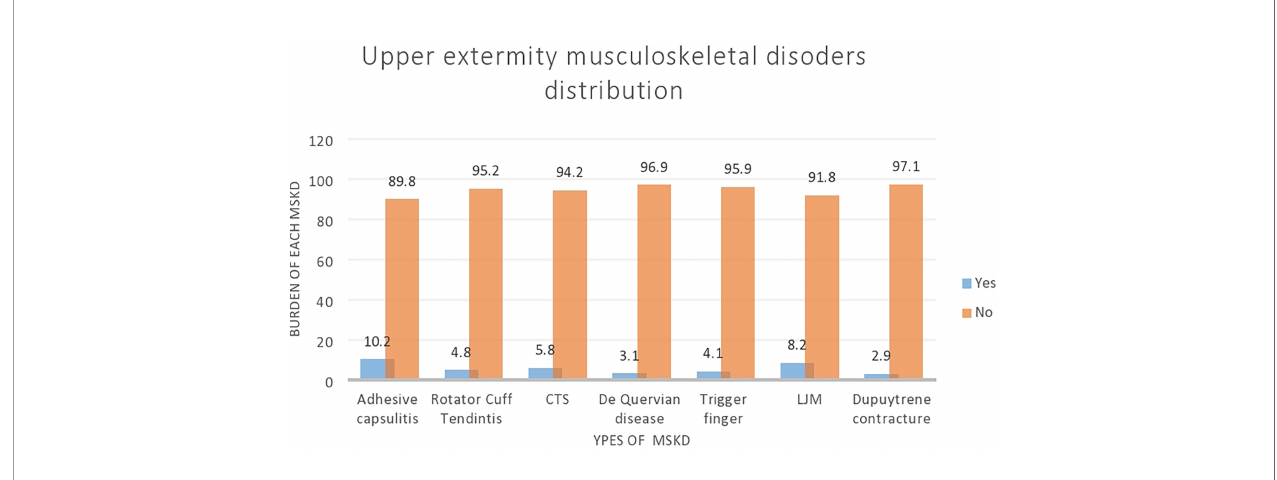
FIGURE 1 | The upper extremity musculoskeletal disorders.